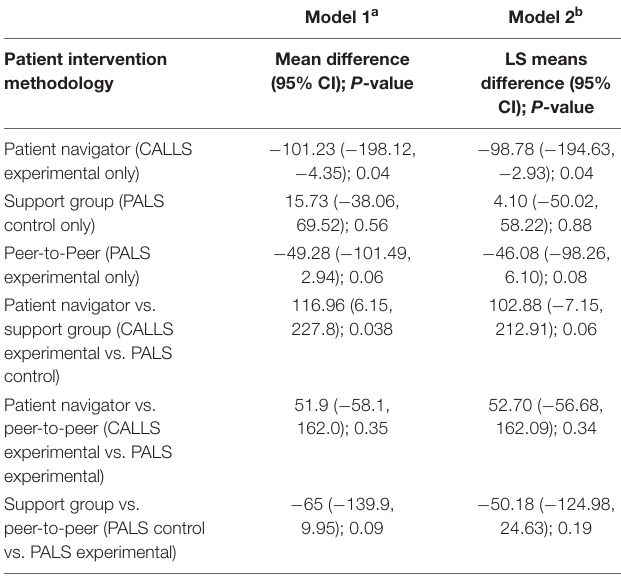
TABLE 3 | Differences in mean total coping score (Lupus Self-Efficacy) from baseline to post-intervention time points between patient navigator, support group, and peer to peer intervention